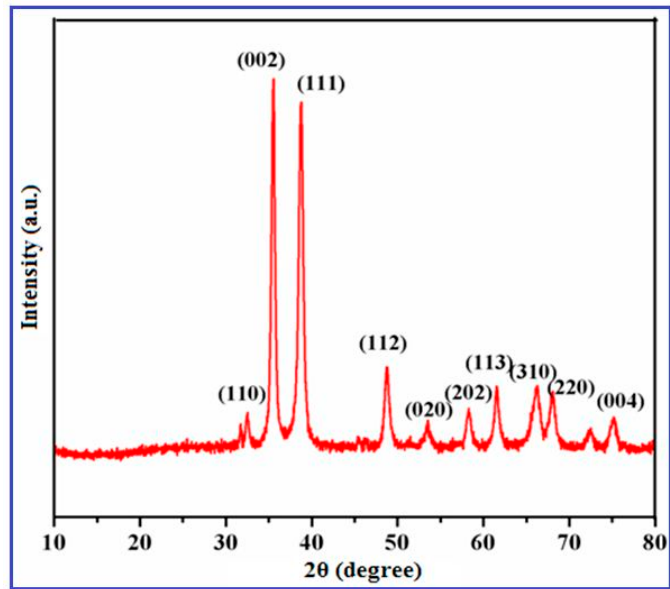
Figure 1. X-ray diffractometry (XRD) pattern of copper oxide (CuO) nanowires synthesized using SMFE.